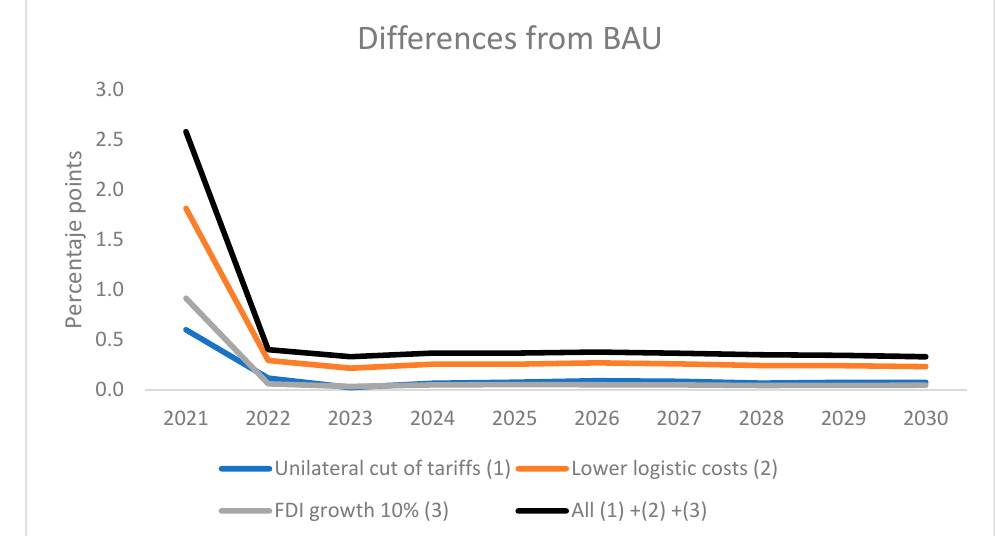
Figure 7. Growth Effects of JET Reforms. Source: Authors’ calculations.